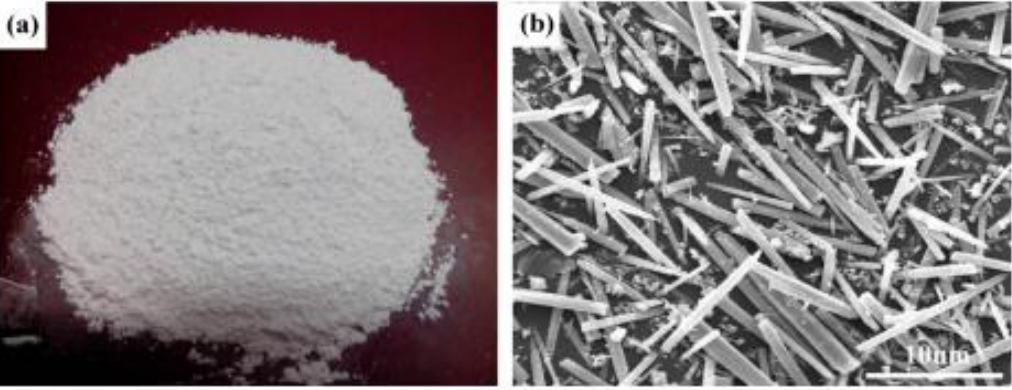
Figure 7. Images of ( a ) macro-morphology of calcium carbonate whisker (CW); ( b ) micro-morphology of CW as shown by SEM [56].